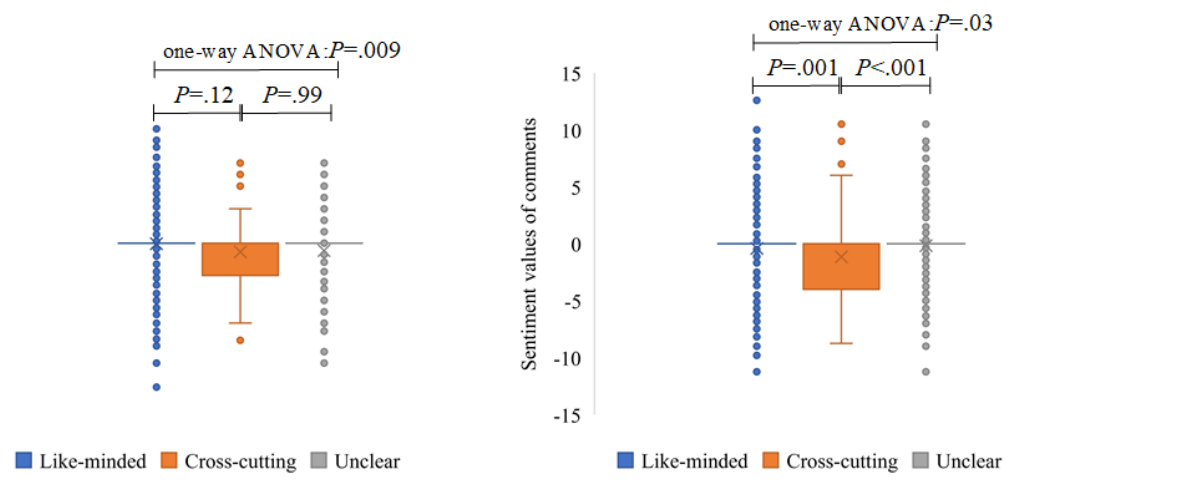
Figure 8. The distribution of sentiment values across different kinds of interactions in retweets (left) and comments (right). The × symbols and circles represent means and outliers of the sentiment values, respectively. ANOVA: analysis of variance.